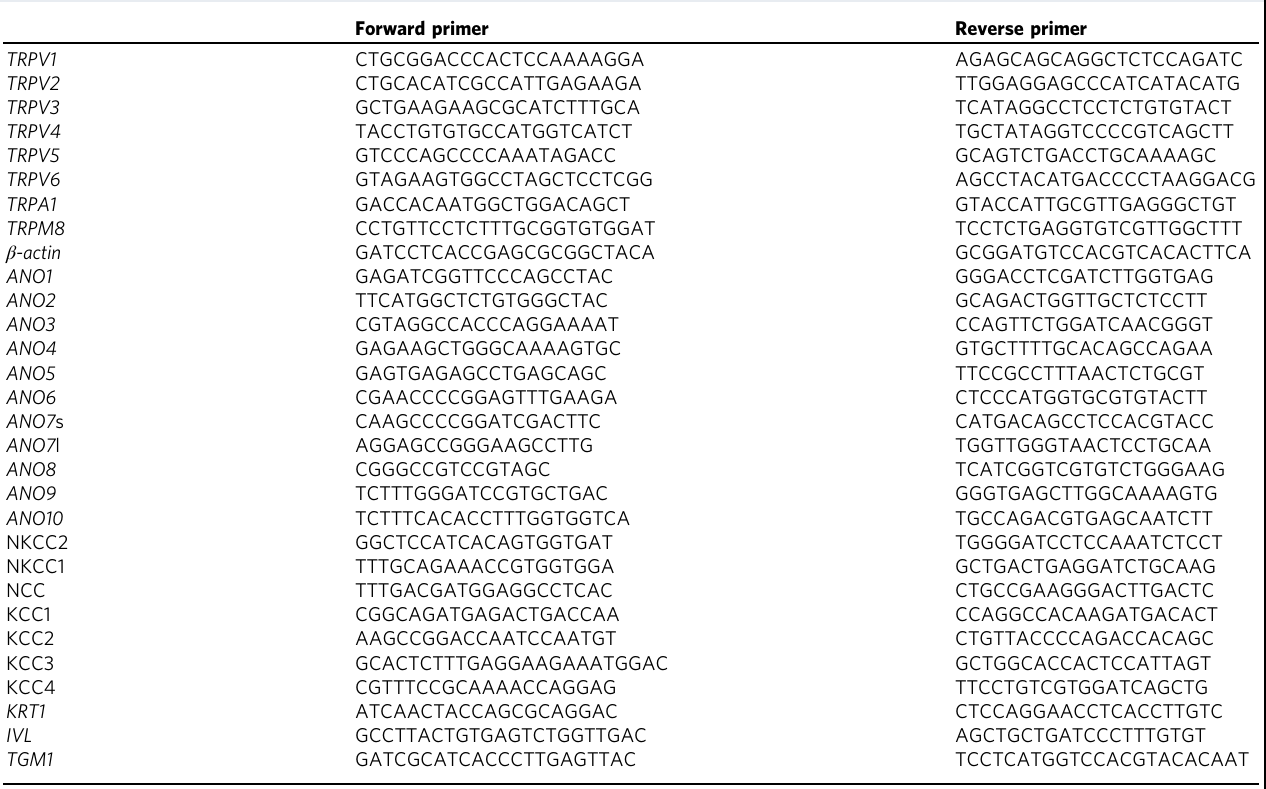
Table 1 Primer list for reverse transcription-PCR